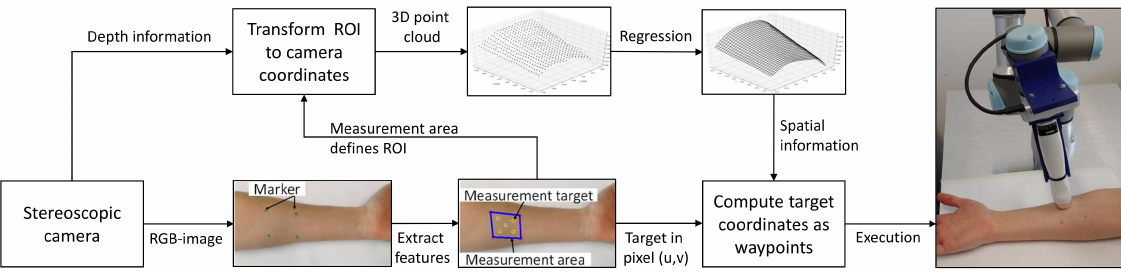
Figure 1. Marker based approach for defining the measurement area